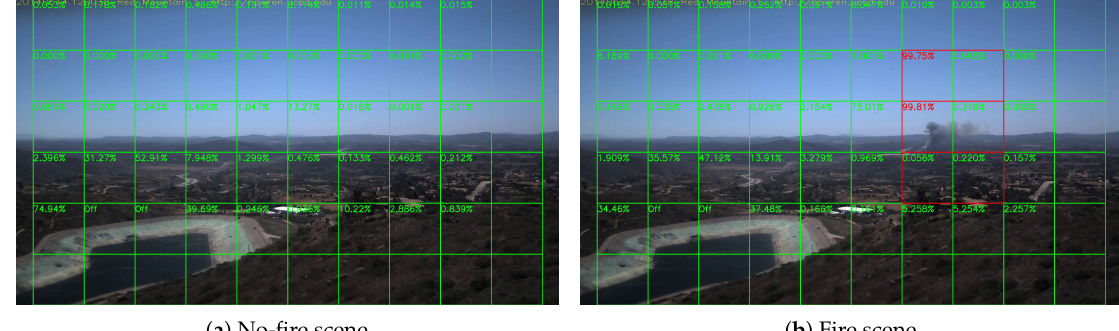
Figure 12. Highway fire, 14 May